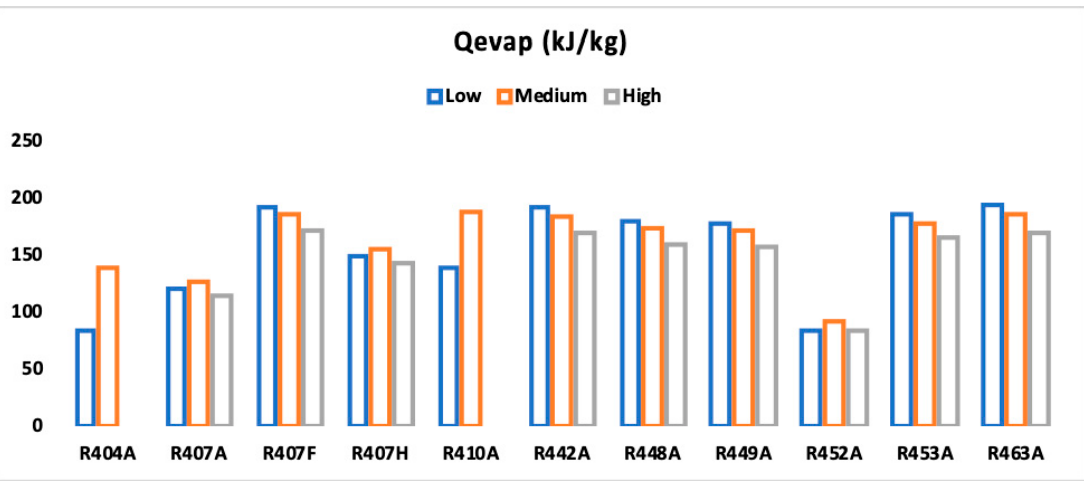
Figure 12. Refrigerant effects of all refrigerants.